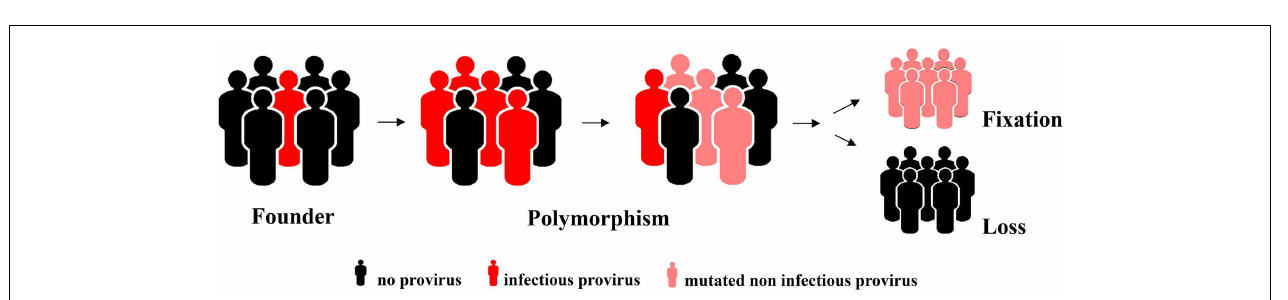
FIGURE 1 | Hypothetical model for an increase in allelic frequency and eventual loss or fixation of an endogenized element integrated at a particular chromosomal locus.